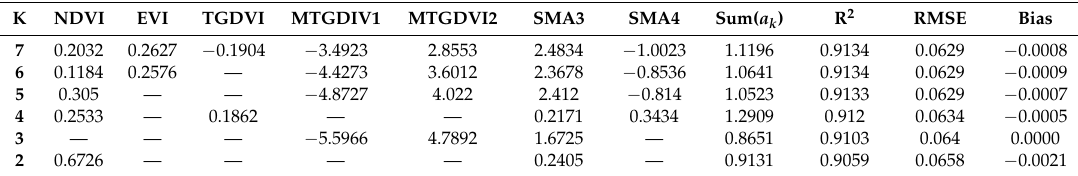
Table 2. Accuracy performances of different combinations of individual models using the MLR method (K standards for the number of individual models used in the combination method). RMSE is the root mean square error. R 2 is determination coefficient.